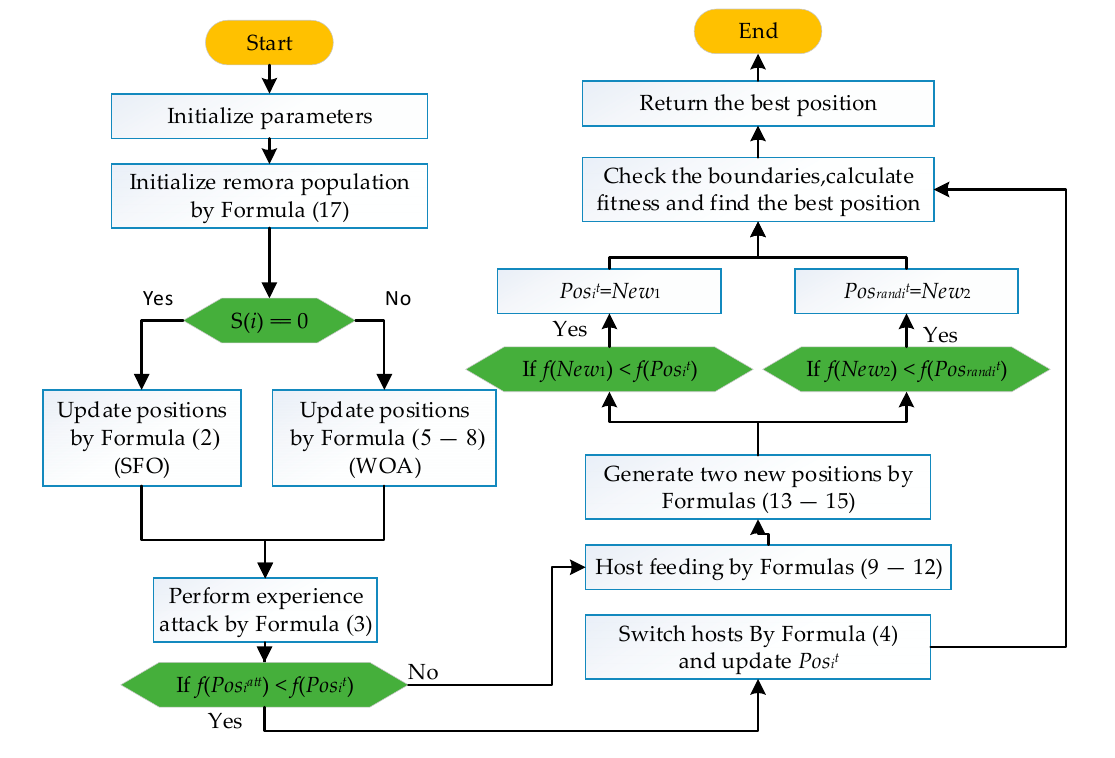
Figure 3. The flowchart of the IROA.